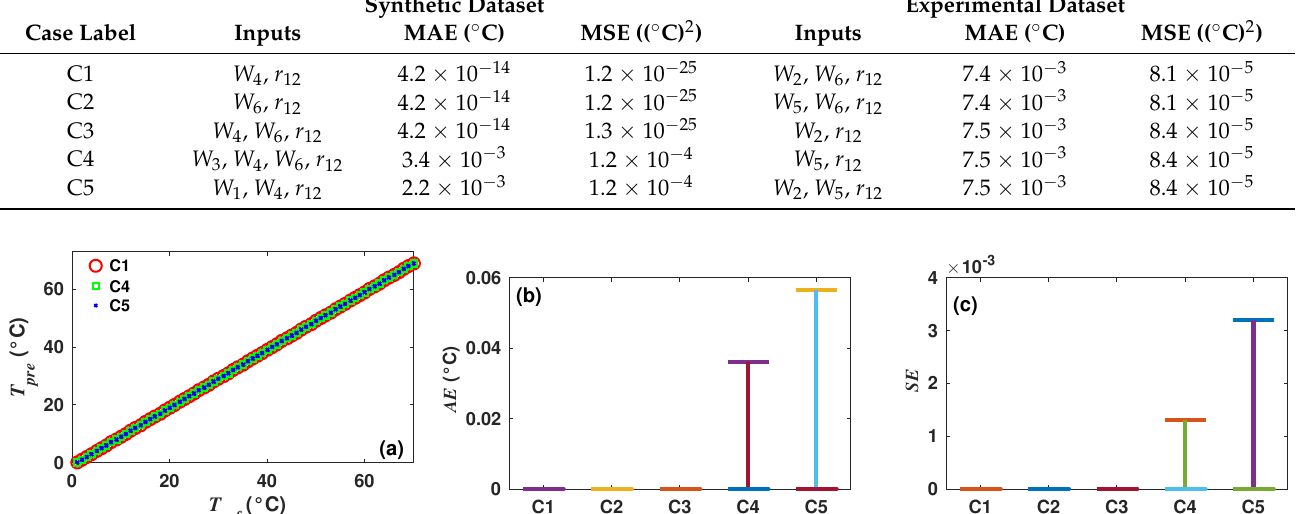
Table 4. MAE and MSE obtained for different combinations of inputs in the FIS for synthetic and experimental datasets of sensor 1.